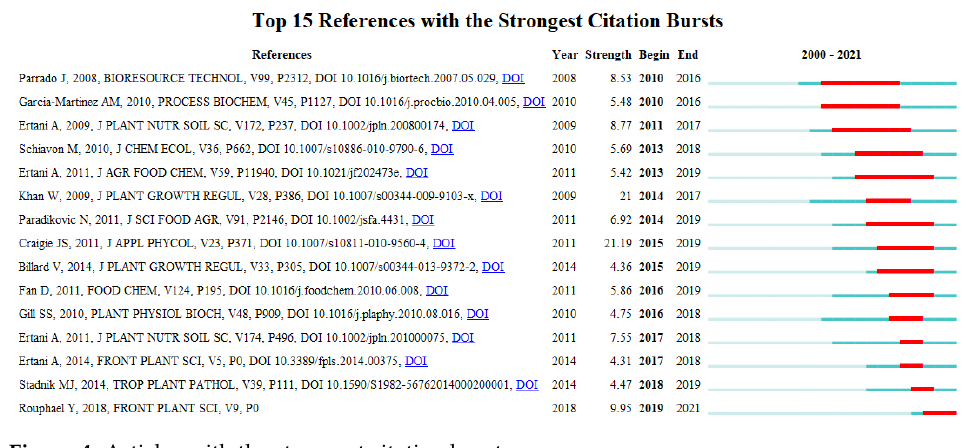
Figure 4. Articles with the strongest citation burst.